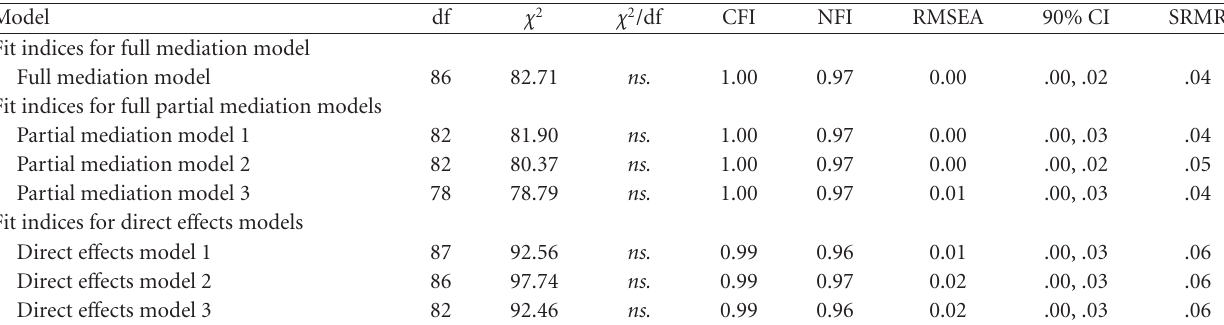
Table 2: Summary of fit indices.